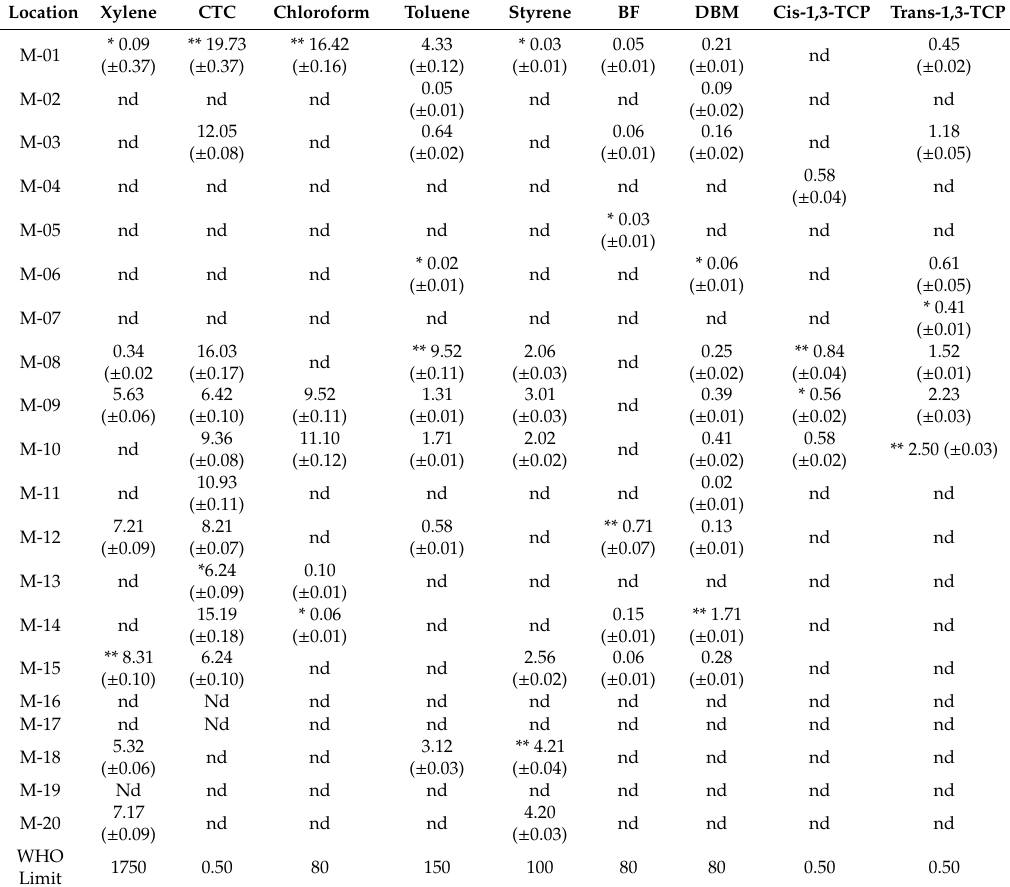
Table 4. Minimum and maximum concentrations, SD ± and allowable limits of the World Health Organization (WHO).